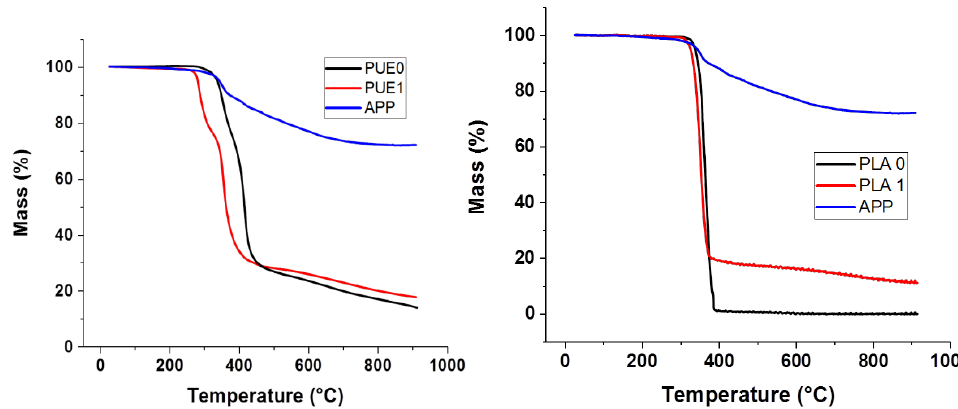
Figure 2. Thermo-Gravimetric Analysis (TGA) for PUE/APP and PLA/APP composites.